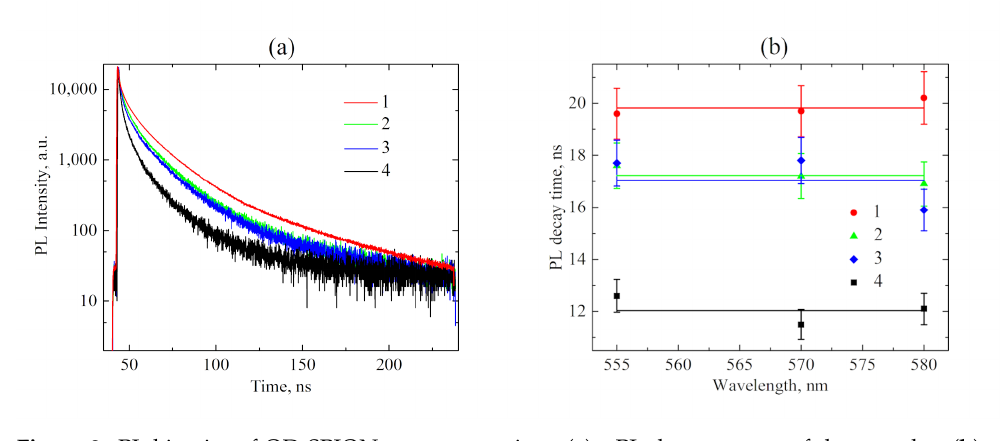
Figure 2. PL kinetics of QD-SPION nanocomposites. ( a )—PL decay curves of the samples; ( b )— Dependence of the sample average PL decay times calculated using formula (2) on the acquisition wavelength; 1—free QDs (red), 2–4—mixture (SPIONs/QDs) with n (C SPIONs : C QDs ) = 0.2 (green); 0.5 (blue); 1 (black), samples in DMSO